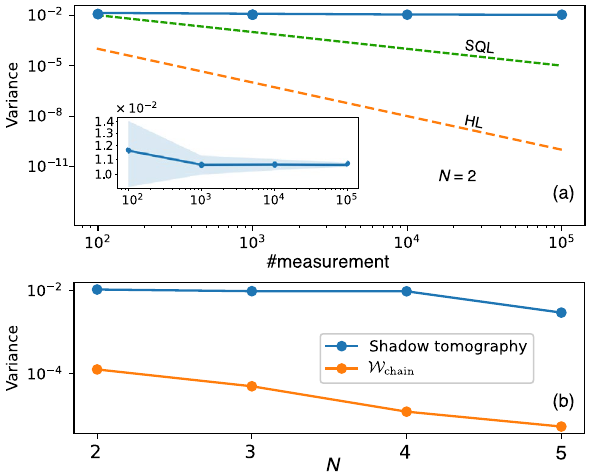
Figure 4. Comparison between the UC-QST approach and the shadow tomography method. ( a ) Log–log z plot of the variance Var versus the number of repeated measurements (#measurement) using the shadow [ˇ ] tomography. The standard quantum limit (SQL) and Heisenberg limit (HL) are shown for comparison purposes. 2 . Inset: Zoom-in the variance, where the blue area is the standard The number of qubits is fixed at N = deviation after talking ten runs. ( b ) Plot of variance for the shadow tomography (blue) and UC-QST (orange). 10 5 , and for the UC-QST, we use the structure of W chain For the shadow tomography, we fix #measurement = and the Adam optimizer, the number of shots is 10 4